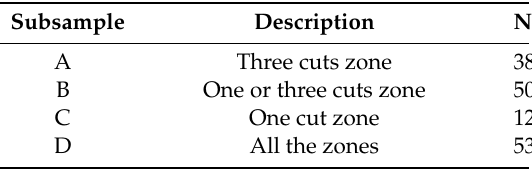
Table 4. Subsample description.